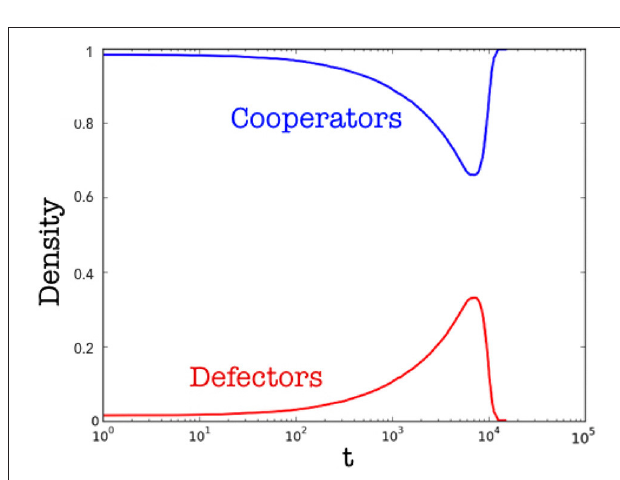
FIGURE 4 | Plots ( a,b ) represent the number of cooperators and that of infected cells ( I ), respectively, over time. Plots ( c,d ) represent the payoff gained by cells and by parasites over time, respectively. In all plots, the blue line represents results achieved by T = 35, while the red one those achieved by T = 36. Results are averaged over different runs.